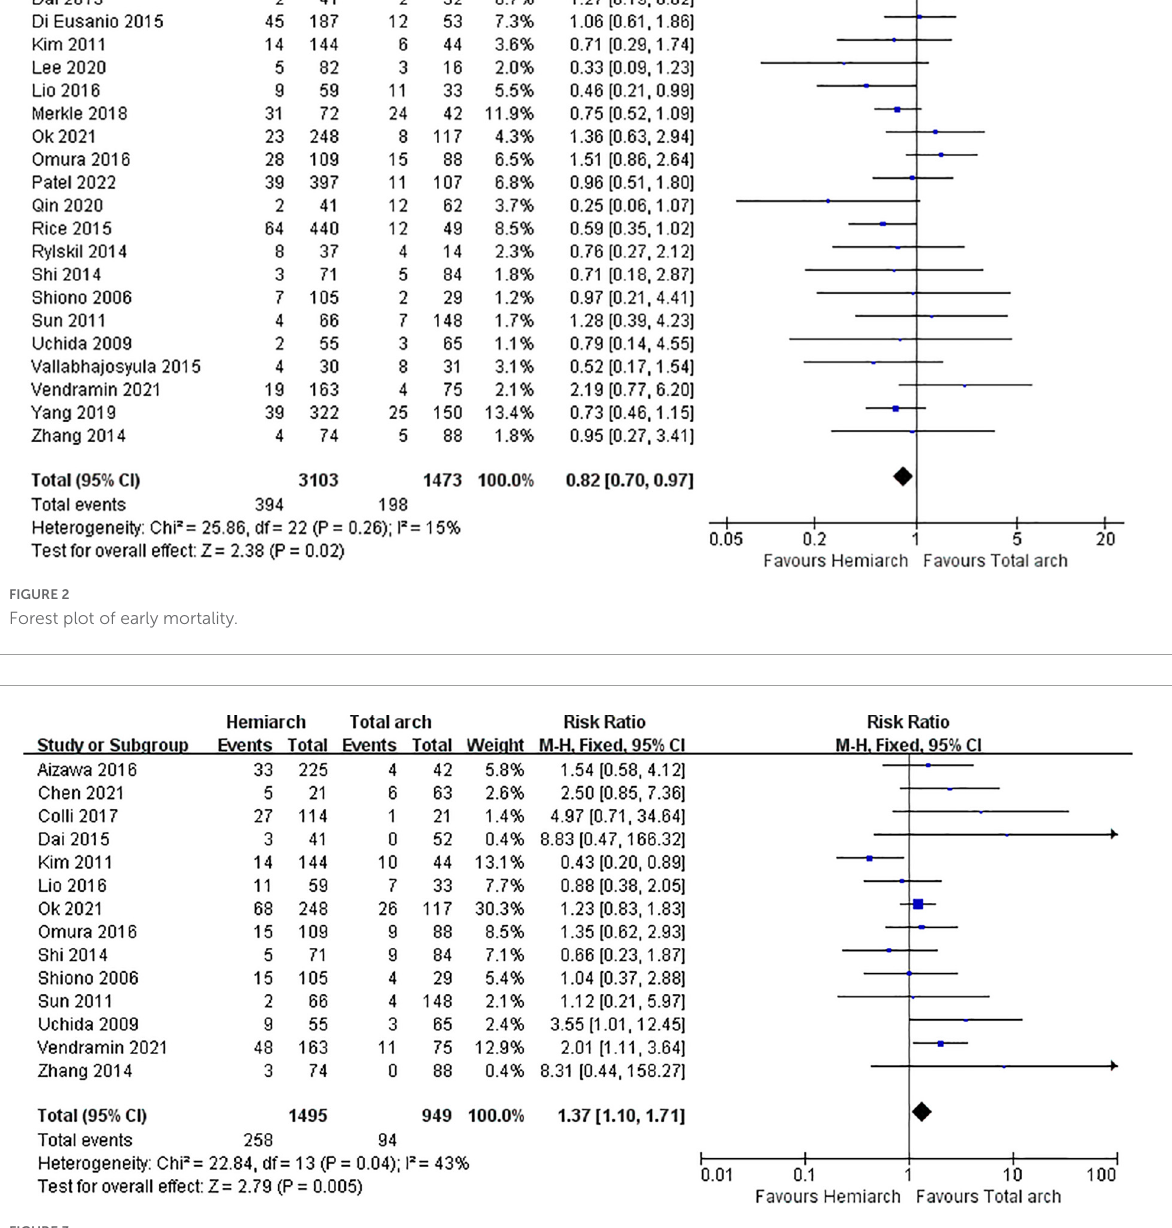
FIGURE3 Forest plot of late